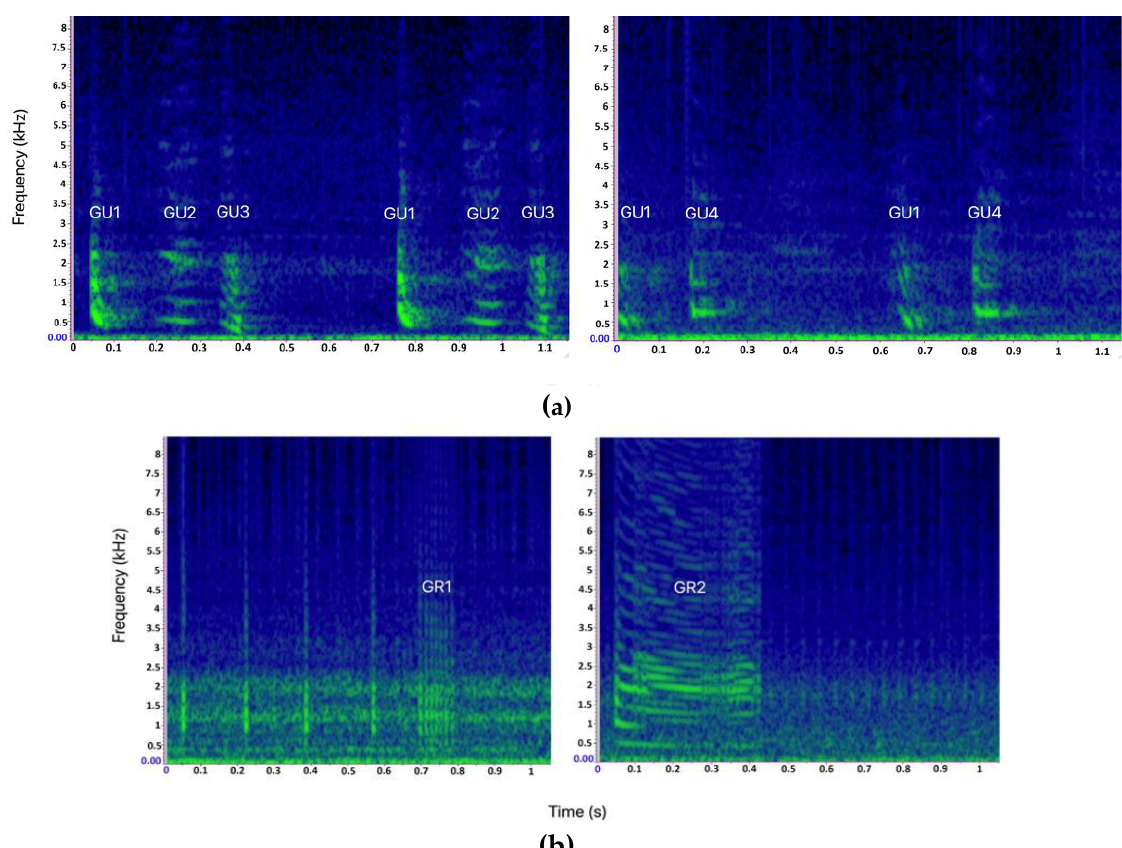
Figure 3. ( a ) Spectrograms of the 4 different Gulp variants (GU1, GU2, GU3, and GU4) identified in this study. ( b ) Spectrograms of the two different Grunt variants (GR1 and GR2) identified in this study (Hann window, size 3000, DFT 4096, overlap 80%, hop size 600, sampling frequency 192 kHz, frequency resolution 46.875 Hz, analysis bandwidth 92.16 Hz at -3 dB).